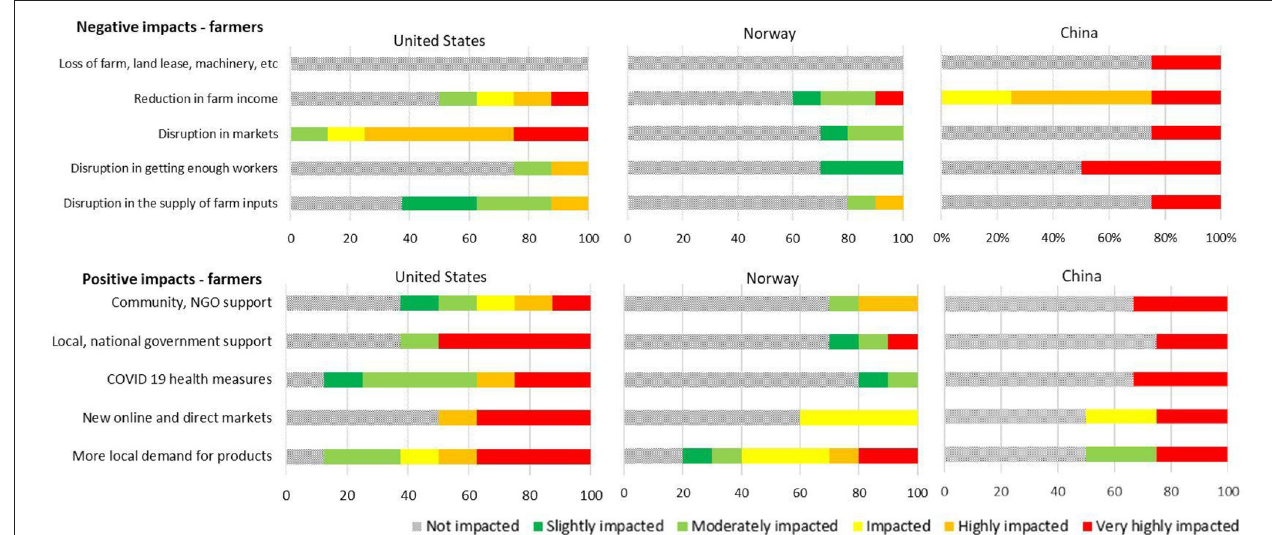
FIGURE 1 | Negative (top pains) and positive (bottom pains) impacts of the COVID-19 pandemic as perceived by the interviewed small-scale farmers and their farm operations, shown as percentage distributions over the six different impact categories (gray = not impacted, green = slightly impacted, light green = moderately impacted, yellow = impacted, orange = highly impacted, red = very highly impacted), in the United States, Norway and China ( n = 23).